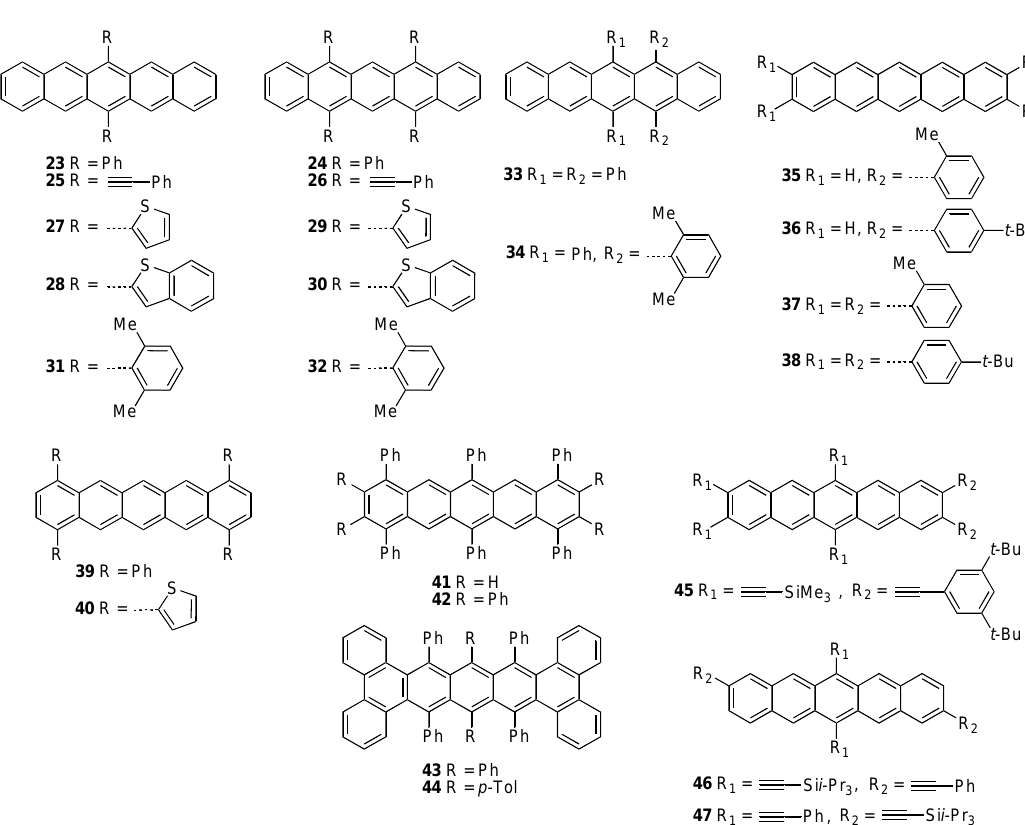
Figure 4. Arylated pentacene derivatives 23–47